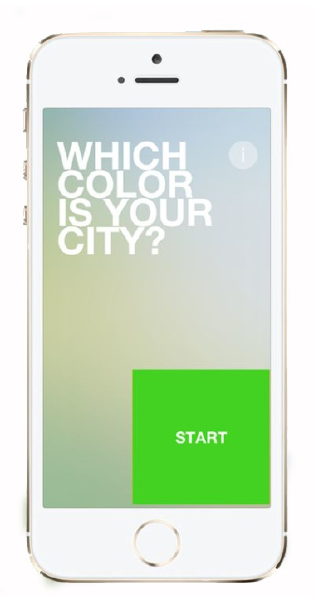
Fig. 8. “W hich color is your city” screen